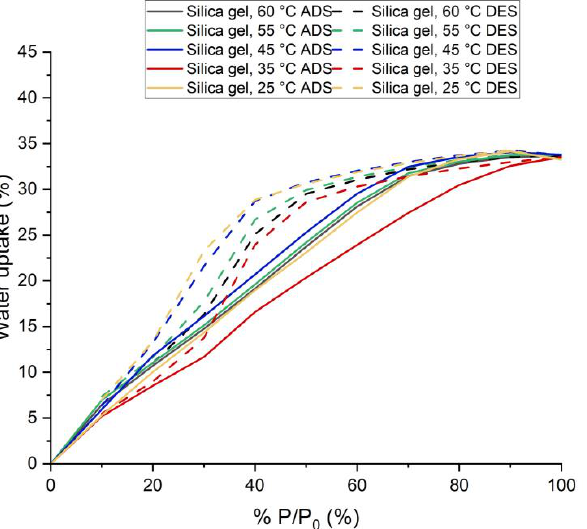
Figure 6. Adsorption and Desorption Isotherms for Silica Gel (at five process temperatures 25, 35, 45, 55 and 60 °C.